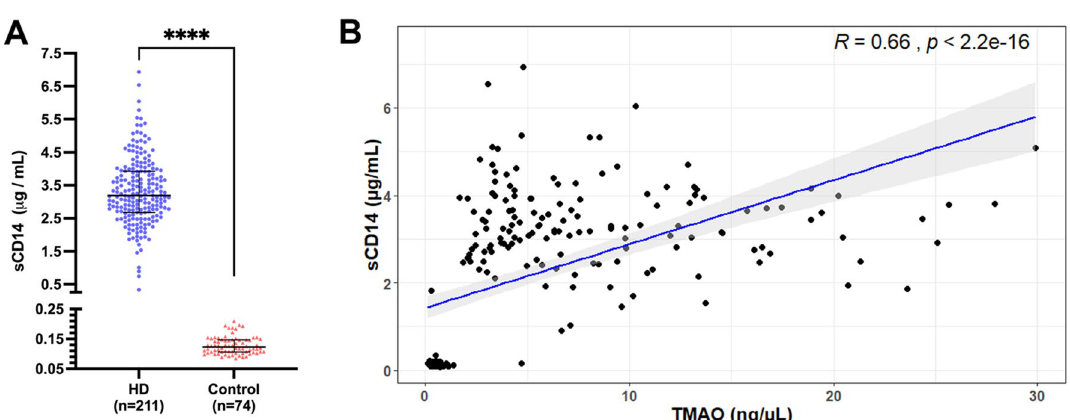
Figure 2. Analysis of soluble CD14 (sCD14) levels in haemodialysis (HD) and non-CKD controls (control). ( A ) Soluble CD14 levels. The number of samples (n) that each analyte was detected in is noted for each group. Data presented at median and interquartile range. Statistical significance, *** p < 0.001, **** p < 0.0001. ( B ) Spearman’s correlation between sCD14 and trimethylamine N-oxide (TMAO)